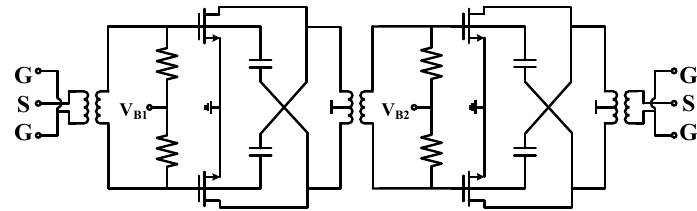
Figure 1. Schematic of the presented E-band PA.